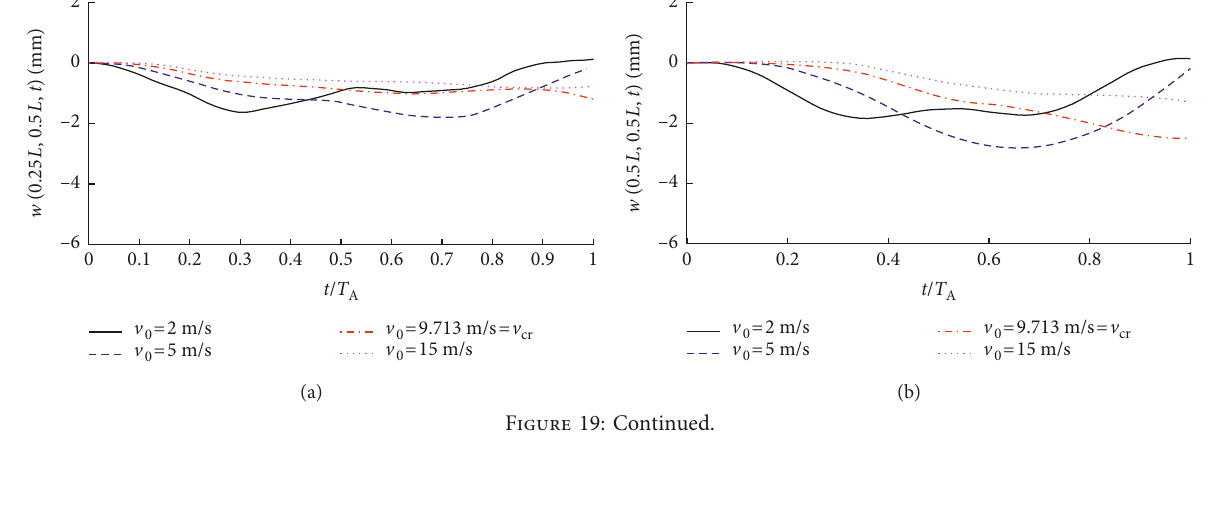
v 0 =9.713 m/s= v cr v 0